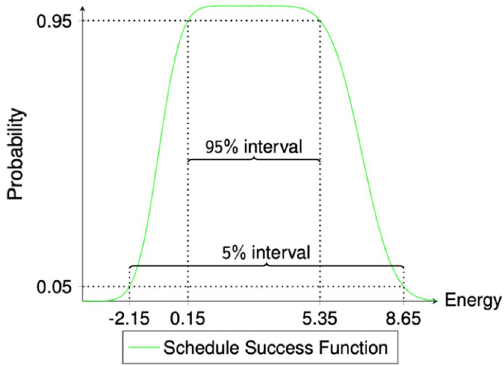
Fig. 3 95% and 5% success interval for the scheduling success